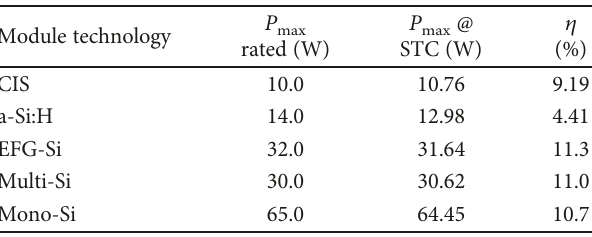
Table 5: Module technologies, rated power, STC-measured power, and aperture area e ffi ciencies of the fi ve modules used in the quality assessment.